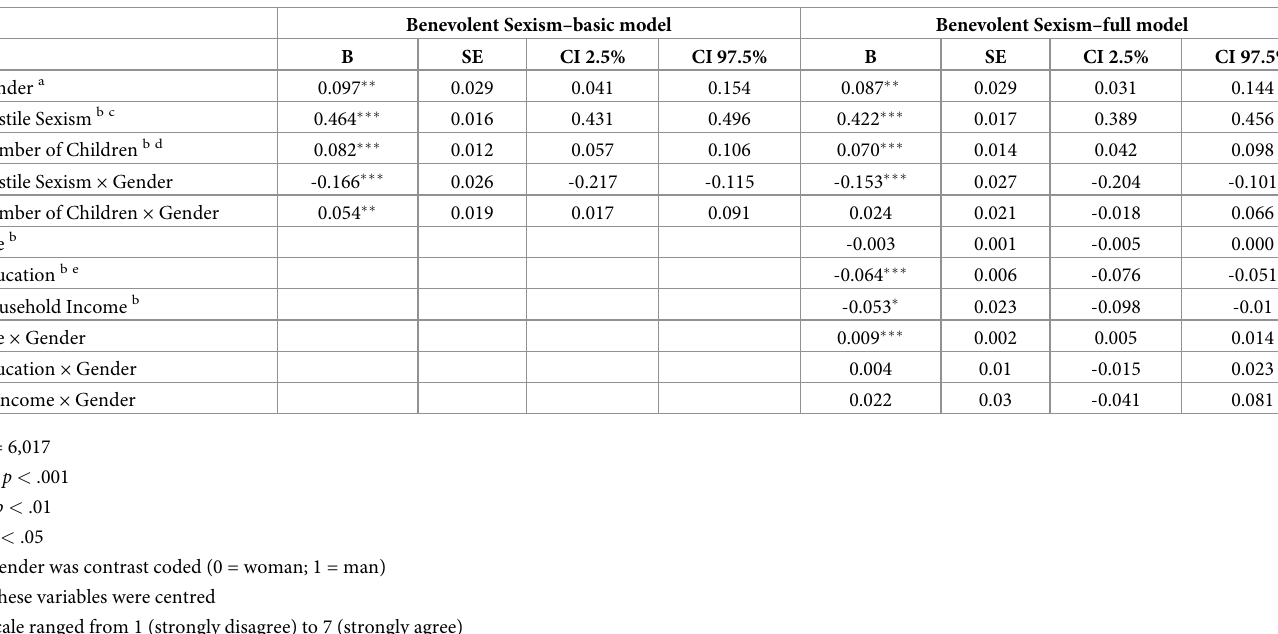
Table 2. Cross-sectional multiple regression models predicting benevolent sexism at